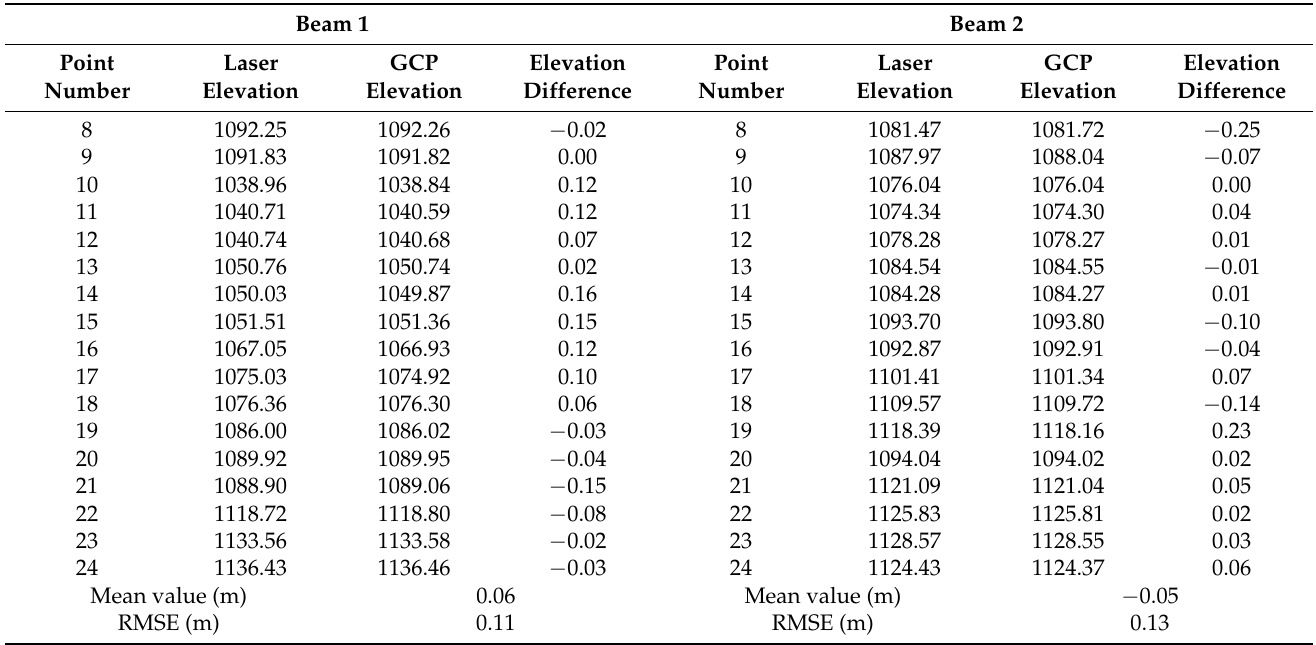
The line graphs shown in Figure 10 are used to visually display the GF-7 satellite laser elevation accuracies after the first and second calibrations using the AW3D30 DSM and the first iteration using the LiDAR reference data.